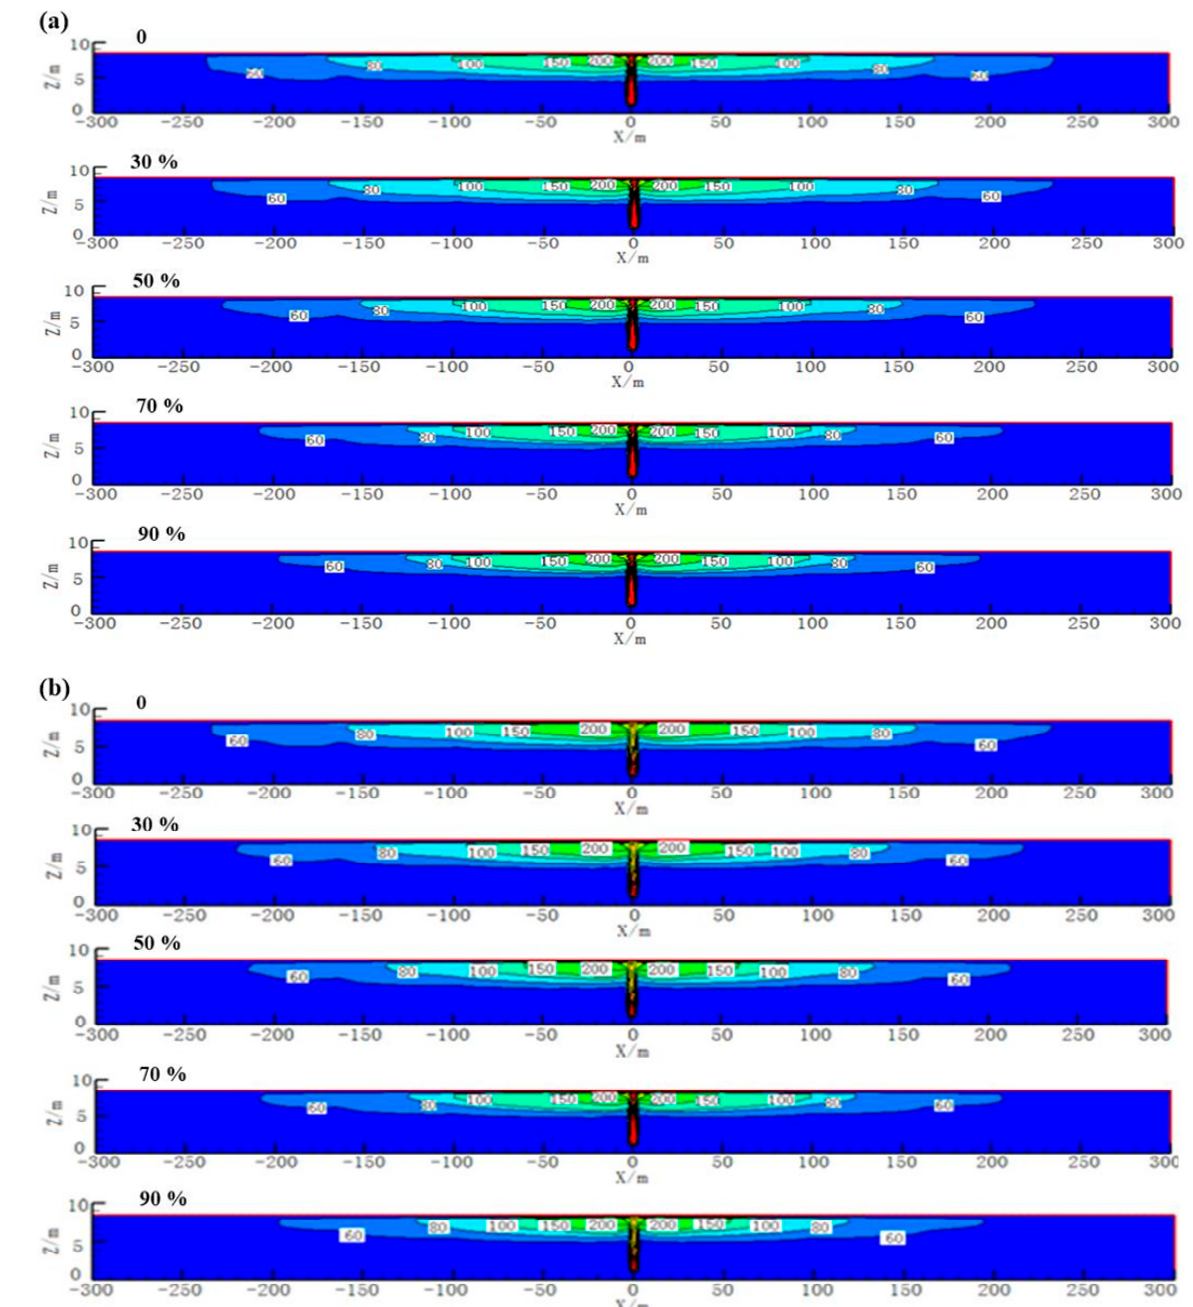
Figure 2. Smoke temperature distribution in central surface under different air supply volume: ( a ) sidewall exhaust; ( b ) top exhaust.